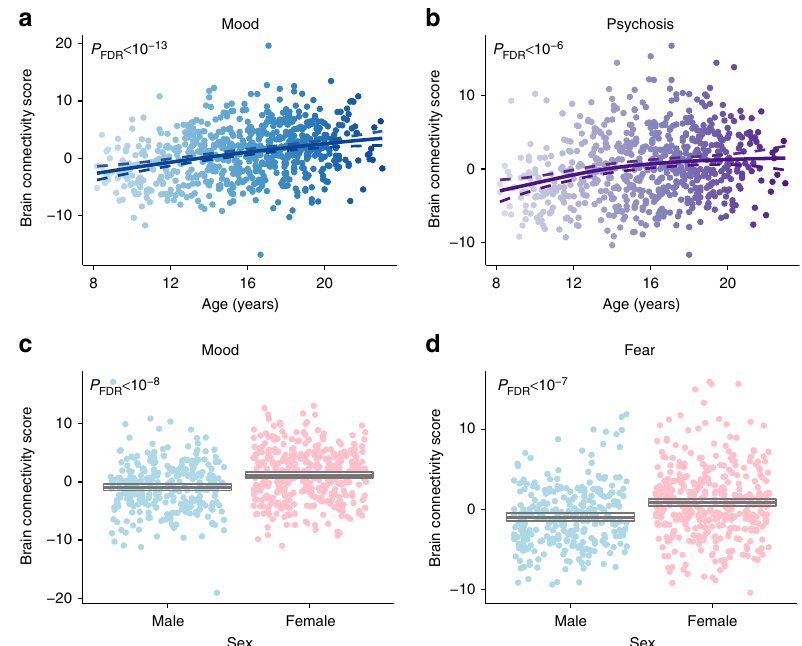
Fig. 7 Developmental effects and sex differences are concentrated in speci fi c dimensions. Connectivity patterns associated with both the mood ( a ) and psychosis ( b ) dimensions increased signi fi cantly with age. Additionally, connectivity patterns associated with both the mood ( c ) and fear ( d ) dimensions were signi fi cantly more prominent in females than males. Multiple comparisons were controlled for using the False Discovery Rate ( q < 0.05). Dashed lines and boxes indicate the 95% con fi dence interval